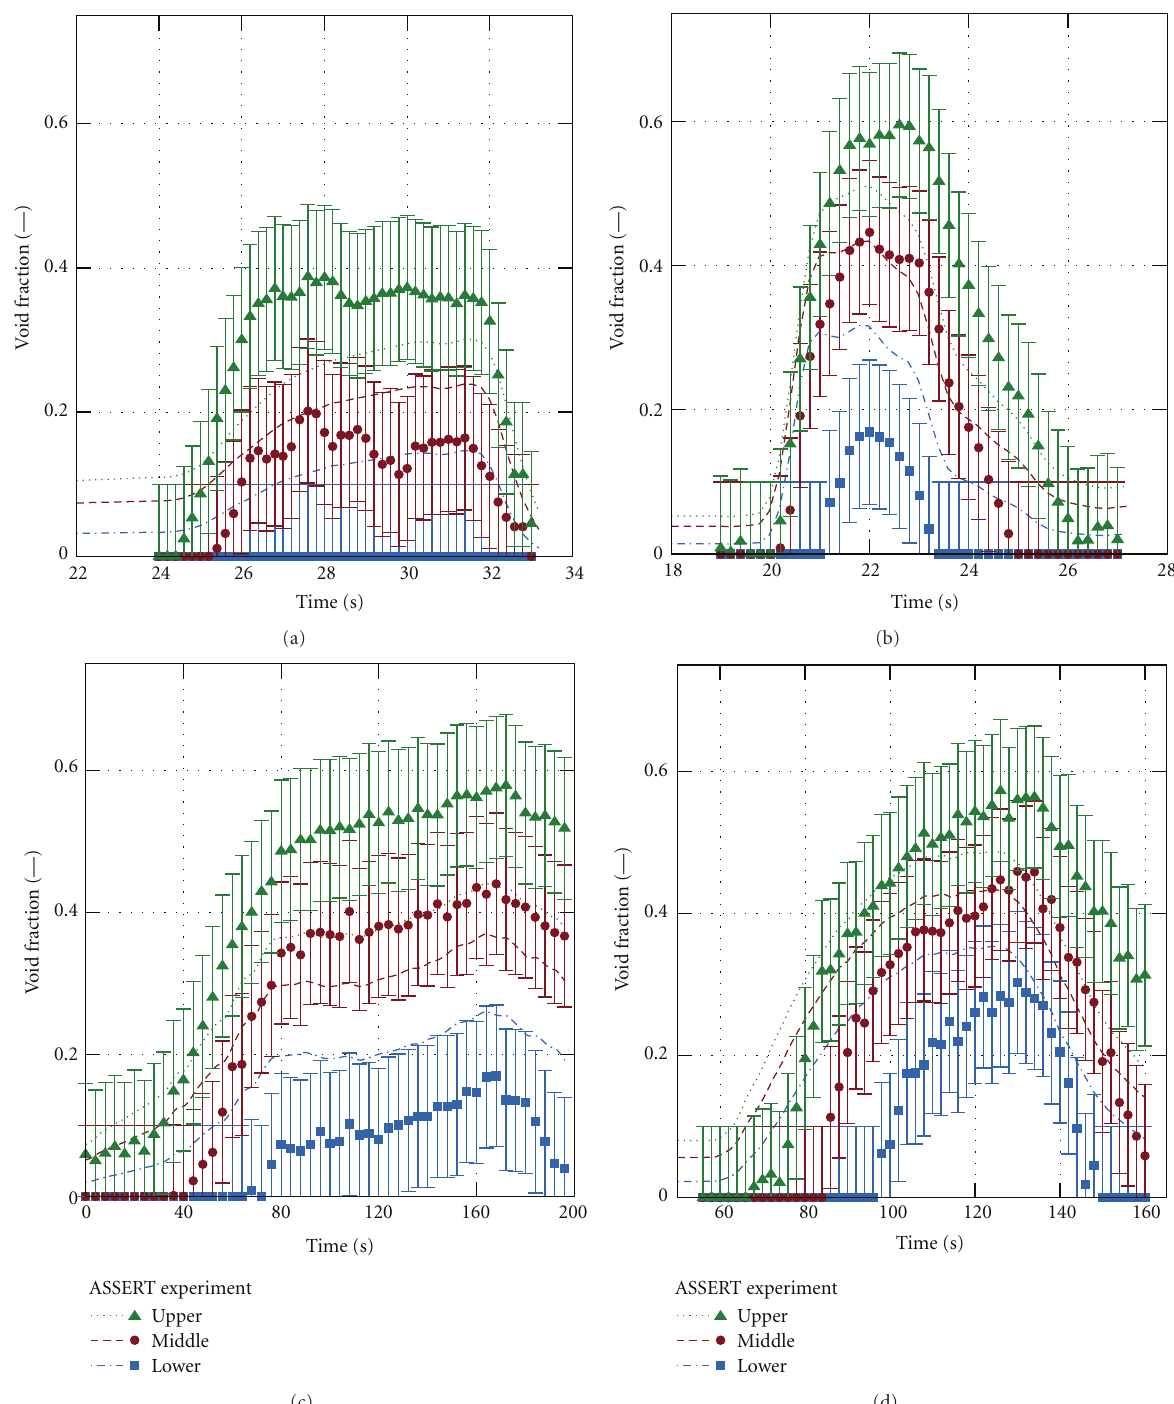
Figure 14: Transient void fraction results for bundle test series B6. Power increase (a), flow reduction (b), depressurization, (c) and inlet temperature increase (d). Error bands displayed correspond to 2 σ exp = 0 .